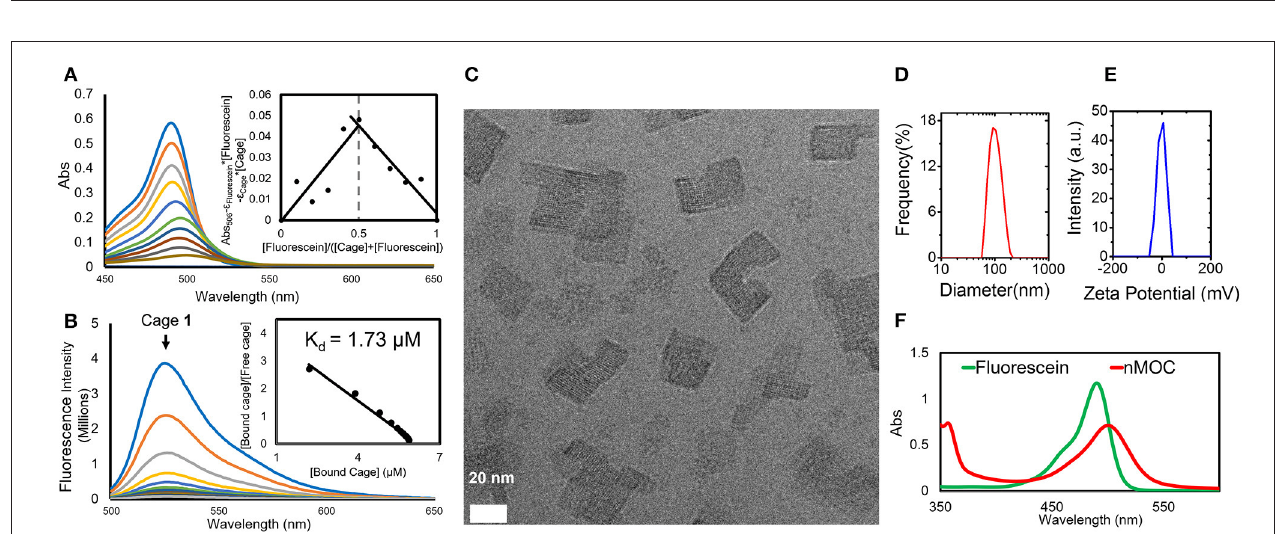
FIGURE 3 | Nanoformulation of Cage 1 using fluorescein (2) and MPEG 5k -PGA 50 (3) . (A) Quenching of fluorescence emission of fluorescein by titration with 1 (6 µ M) and the Scatchard plot extracted from fluorescence titration to determine K d ; (B) Changes of the absorption spectra of the mixture of 1 and 2 in a different molar ratio (0–1.0) and the Job plot extracted from titration to determine the binding ratio of 1 and 2 .; (C) A cryo-EM image (Scale bar: 20nm) (D) DLS analysis of size distribution; (E) Zeta-potential analysis; (F) UV-vis spectra of fluorescein and nMOC in PBS ([ 2 ] = 20 µ M).